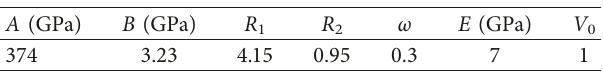
Table 3: Parameters of the state equation of dynamite JWL.